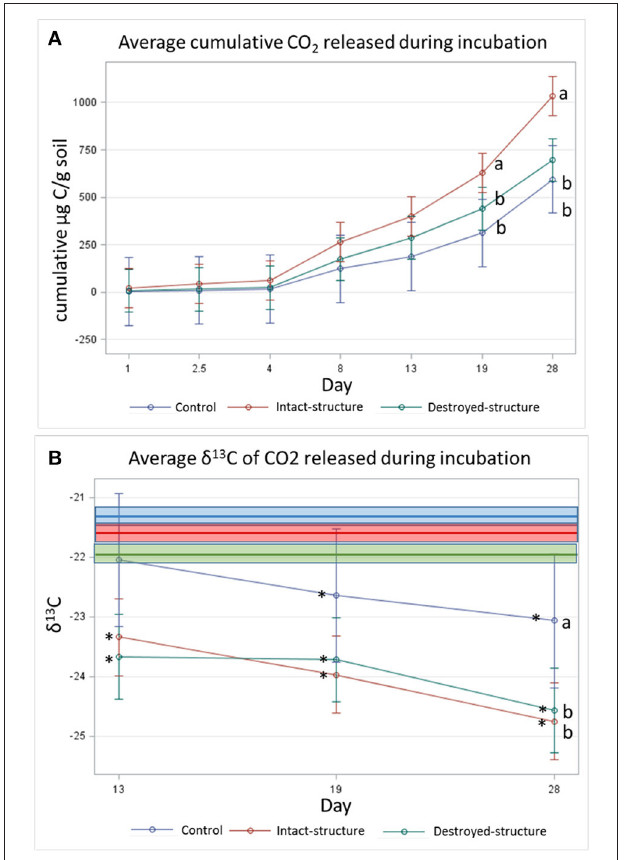
FIGURE 5 | (A) Cumulative CO 2 and (B) average isotopic signature of CO 2 respired during 28 day incubation experiment. Bars represent standard errors. Bold lines indicate the mean δ 13 C values of the soil fragment sections prior to incubation for each treatment while boxes indicate the standard errors ( − 22.0 ± 0.1, − 21.4 ± 0.1, and − 21.6 ± 0.1 ‰ for destroyed-structure, intact-structure, and control, respectively). Letters indicate significant differences among treatments at α = 0.05. Stars indicate significant differences between the δ 13 C of the emitted CO 2 and the soil sections Pre at α = 0.05.